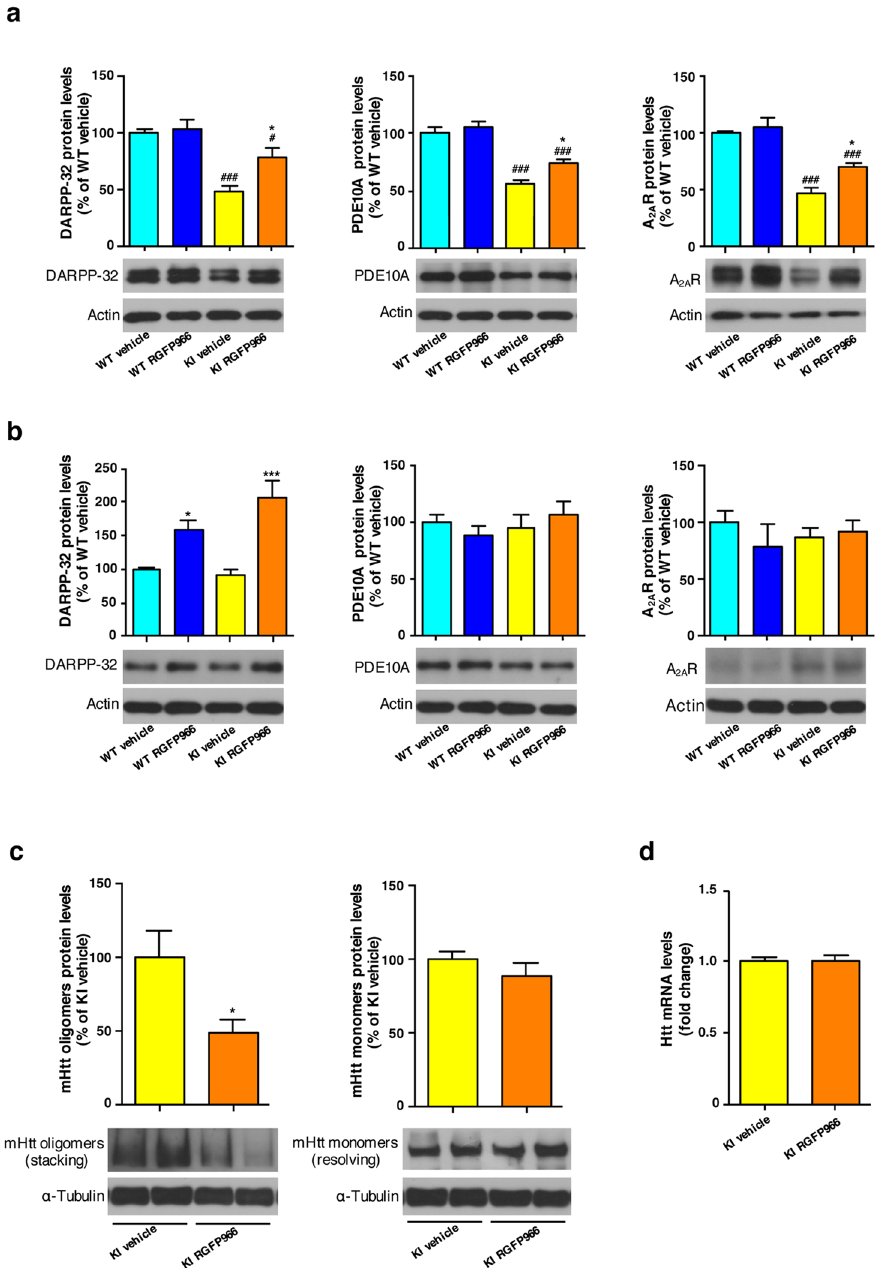
Figure 7. RGFP966 treatment ameliorates striatal pathology in HD mice. (a) Representative immunoblots showing striatal protein levels of DARPP-32, PDE10A and A 2A R, with actin as loading control in vehicle and RGFP966 chronically treated Hdh Q7/Q7 (WT) and Hdh Q7/Q111 (KI) mice. * p < 0.05 compared to vehicle-treated KI mice; # p < 0.05; ### p < 0.001 compared to vehicle treated WT mice by two-way ANOVA with Bonferroni post- hoc analysis. Data represent the mean ± SEM (n = 6–11 animals per group). (b) Representative immunoblots showing striatal protein levels of DARPP-32, PDE10A and A 2A R with actin as loading control in DMSO and RGFP966 treated primary striatal cultures obtained from Hdh Q7/Q7 (WT) and Hdh Q7/Q111 (KI) embryos. * p < 0.05 and *** p < 0.001 compared to DMSO-treated cultures by two-way ANOVA with Bonferroni post- hoc analysis. Data represent the mean ± SEM (n = 4–5 cultures per group). (c) Representative immunoblots showing oligomeric forms of mutant huntingtin (stacking gel), monomeric mutant huntingtin (resolving gel) and α -tubulin as loading control in vehicle and RGFP966 chronically treated Hdh Q7/Q111 (KI) mice. Samples from two different mice are shown in adjoining lanes. All blots have been cropped; the original images are shown in Supplementary Figure 5. * p < 0.05 by Student’s t-test. Data represent the mean ± SEM (n = 6–10 animals per group). (d) Quantitative RT-PCR analysis of Htt mRNA in the striatum of vehicle and RGFP966 acutely treated Hdh Q7/Q7 (WT) and Hdh Q7/Q111 (KI) mice. Levels of mRNA were normalized to 18S and Actin β . Data represent the mean ± SEM (n = 6–7 animals per